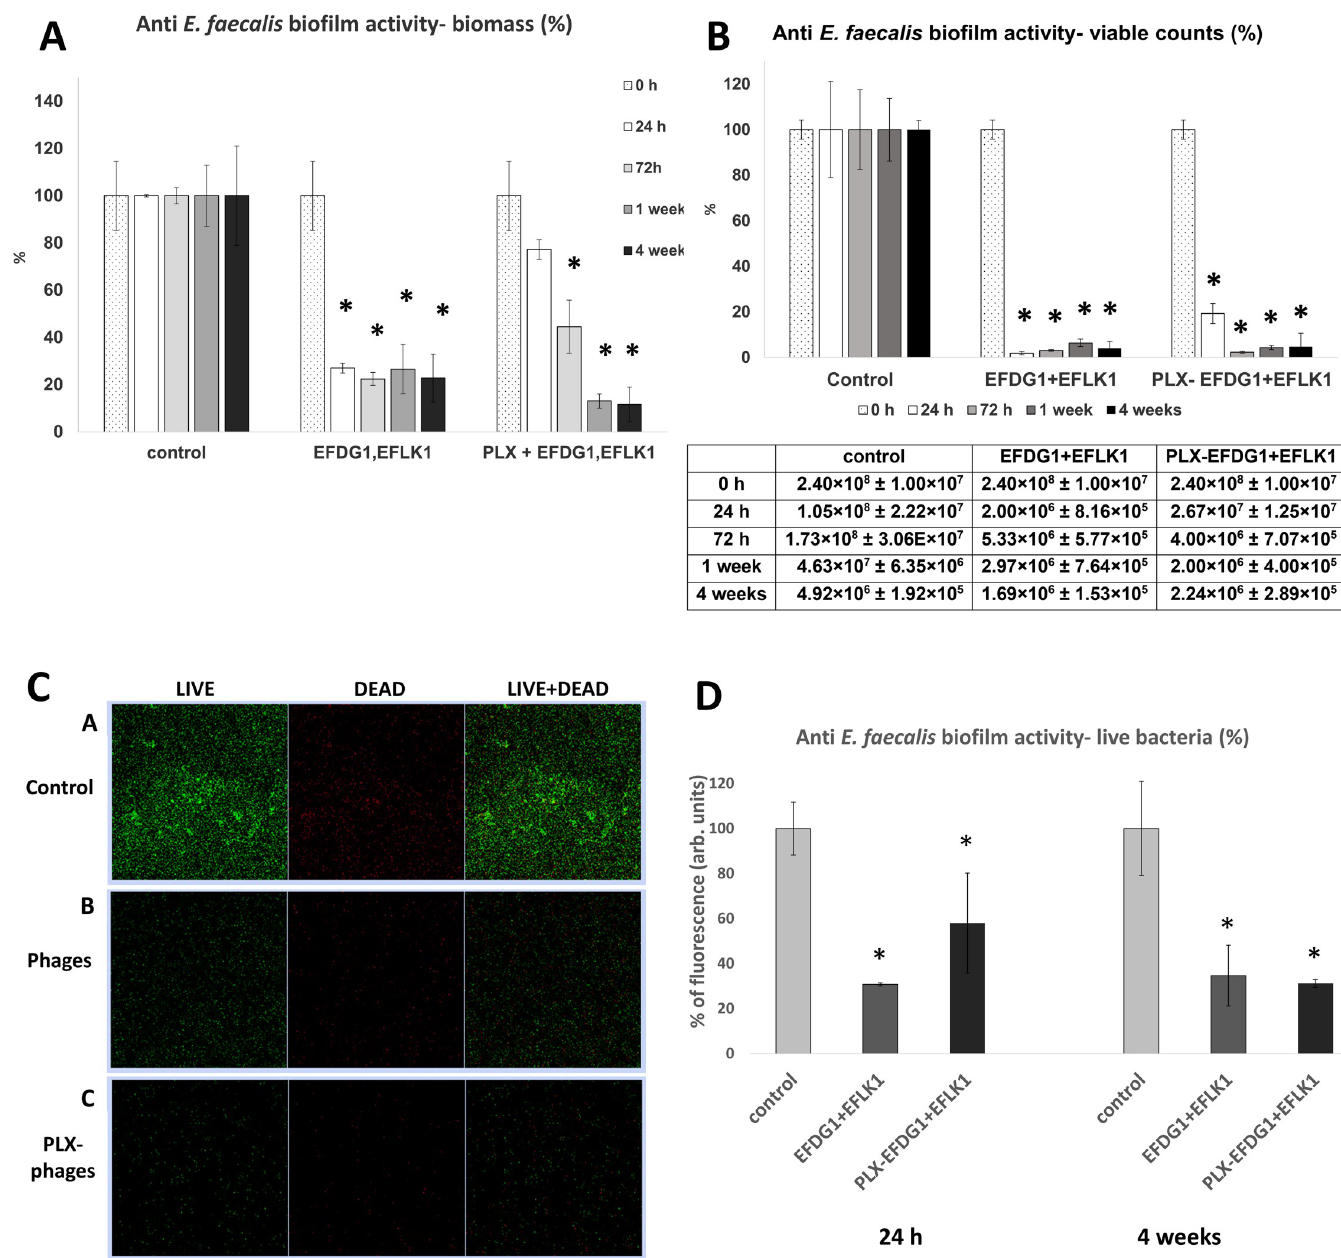
Fig 4. Sustained-release of phages targets E . faecalis biofilm. (A) E . faecalis biofilm biomass decreased following treatment with sustained-release EFDG1/EFLK1 phage cocktail. Treatment with phages and a poloxamer-phage formulation decreased bacterial biofilm biomass, as evaluated by crystal violet staining after 0 h (dots), 24 h (white), 72 h (light gray), 1 week (dark gray), and 4 weeks (black). After 24 h, the phage suspension showed the best antibacterial activity, but after 4 weeks of treatment, the poloxamer-phage formulation reduced biofilm mass most efficiently. The results are presented as percentages, normalized to the biofilm